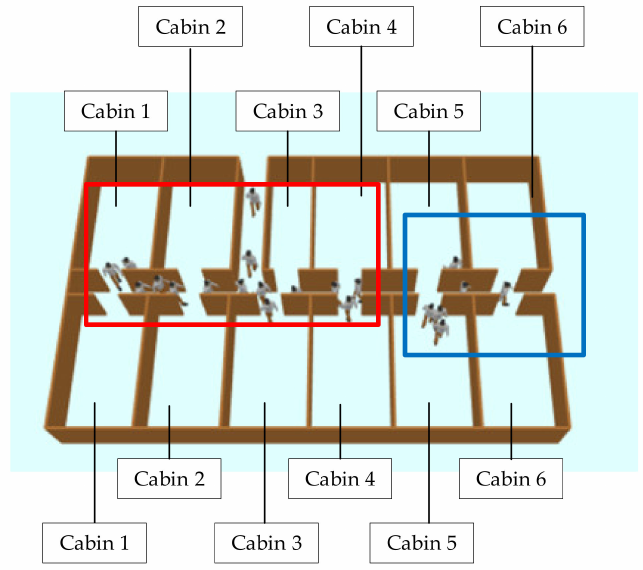
Figure A9. The scenario of test